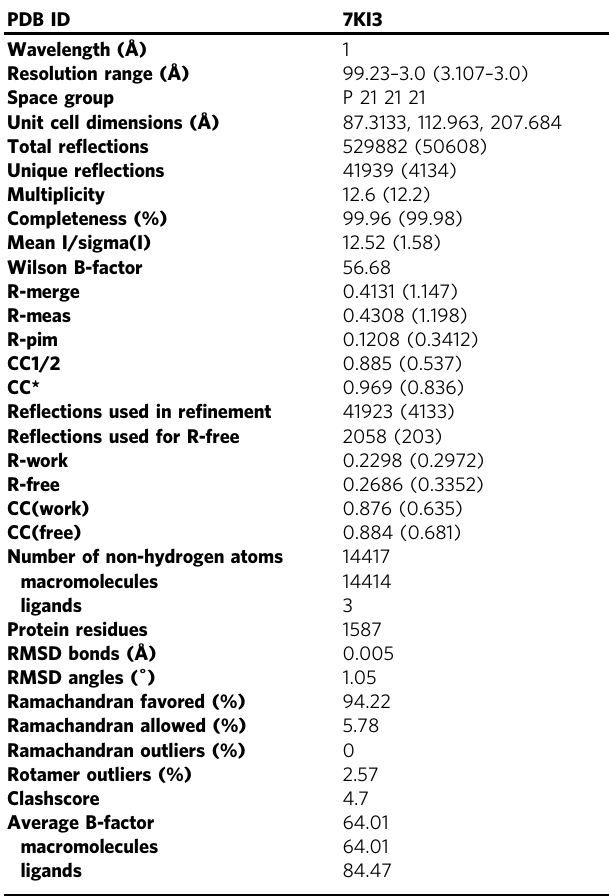
Table 1 Crystallographic Data and Re fi nement Statistics. PDB